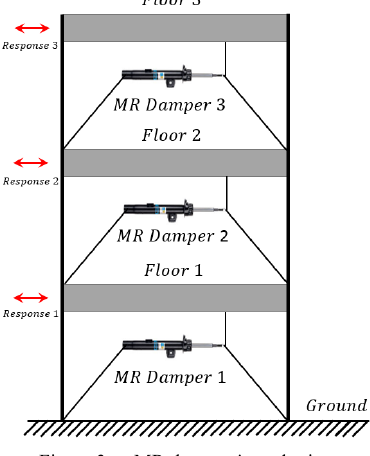
Figure 3. MR dampers' numbering